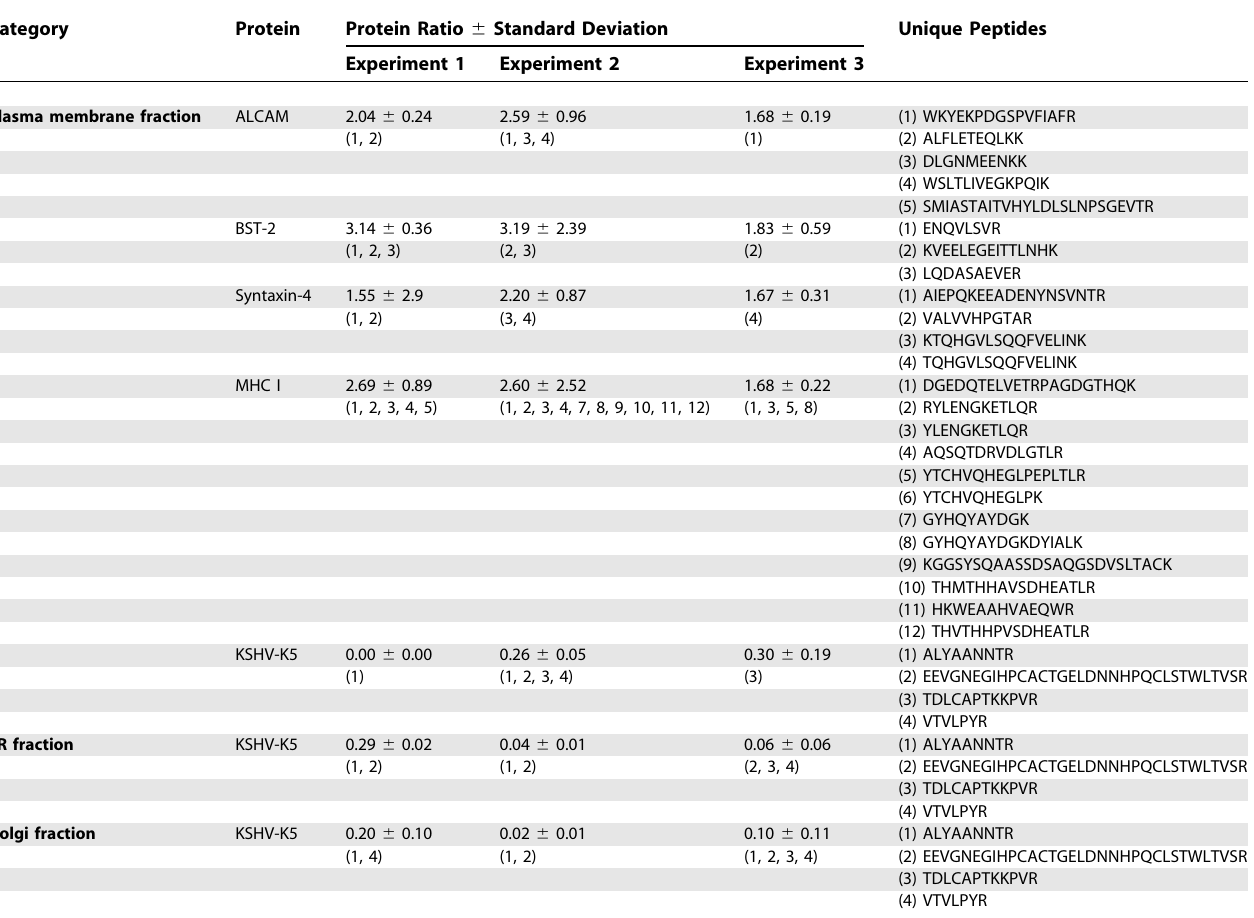
Table 1. SILAC Analysis Yields Three Proteins Displaying Reproducibly Altered Protein Ratios